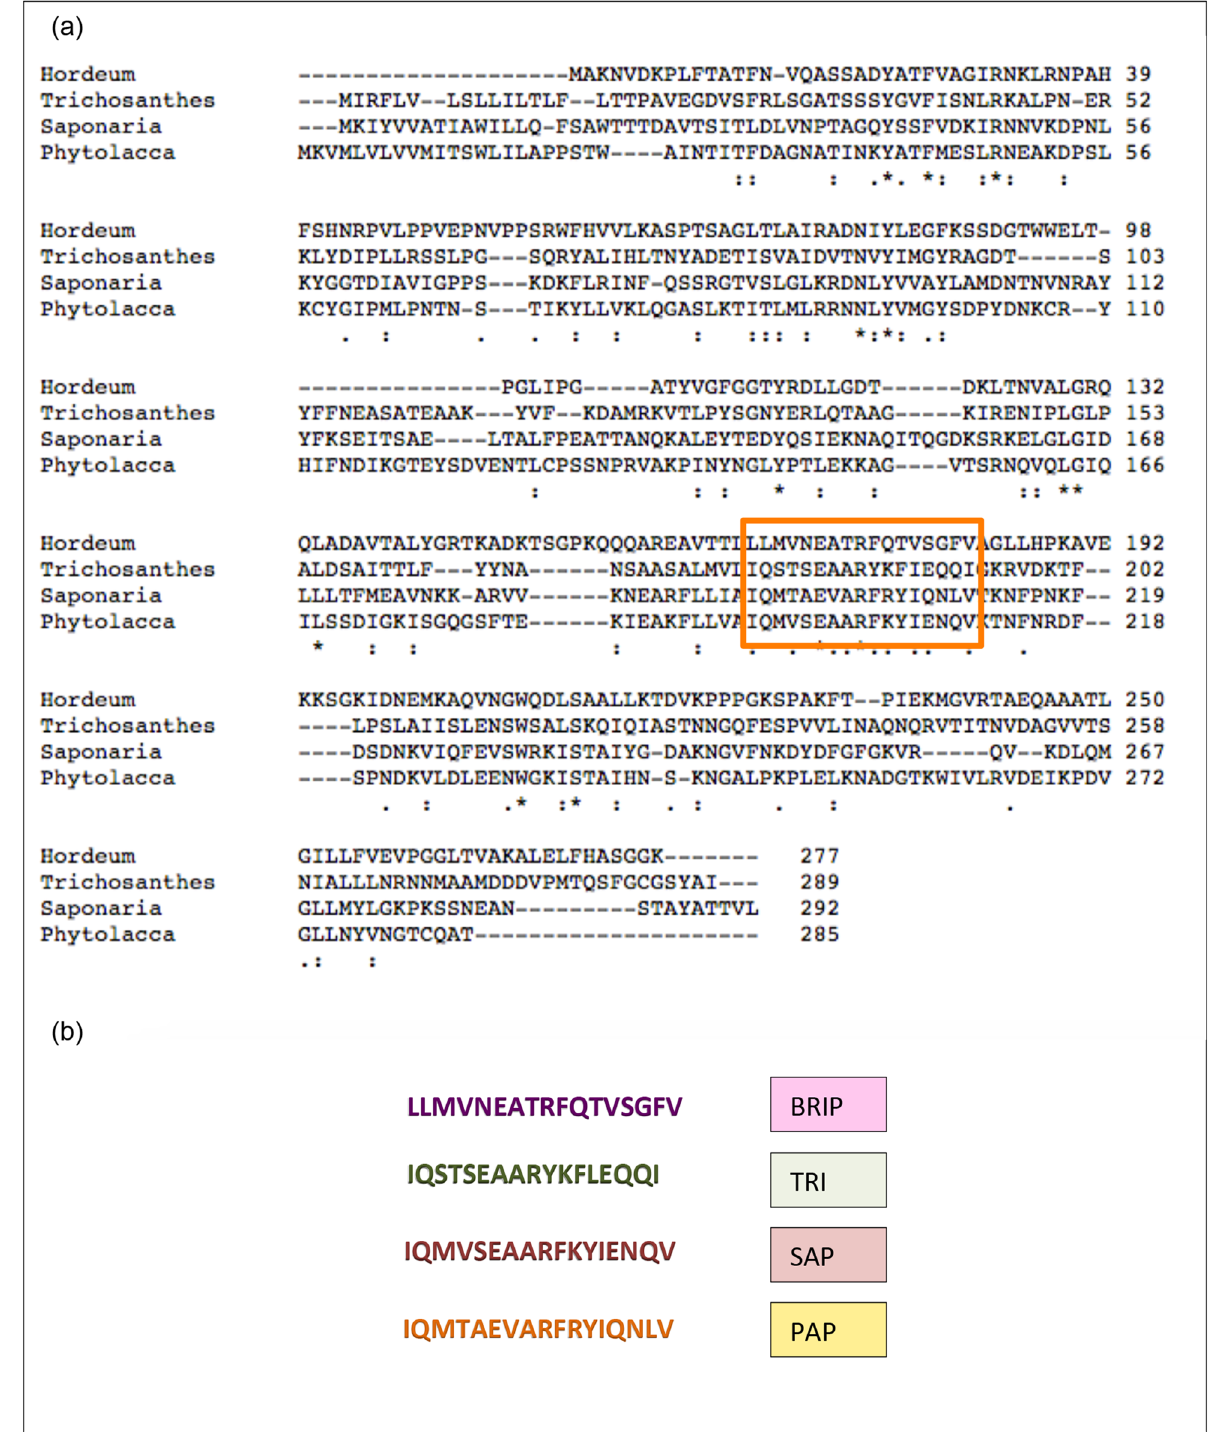
Figure 1. The multiple sequence alignment of type-I RIPs; an antifungal RIP1 from barley; Hordeum vulgare (accession number KAE8814914.1), trichosanthin from Trichosanthes kirilowii (accession number AAA34207.1), saporin from Saponaria officinalis (accession number CAA41948.1), PAP-S1 from Phytolacca americana (accession number KT630652.1.) with conserved ricin/shiga toxin domain (predicted by ExPASY PROSITE) boxed ( a ). ( b ) The sequences of ricin- peptides retrieved from barley RIP (BRIP), trichosanthin (TRI), saporin (SAP) and PAP-S1